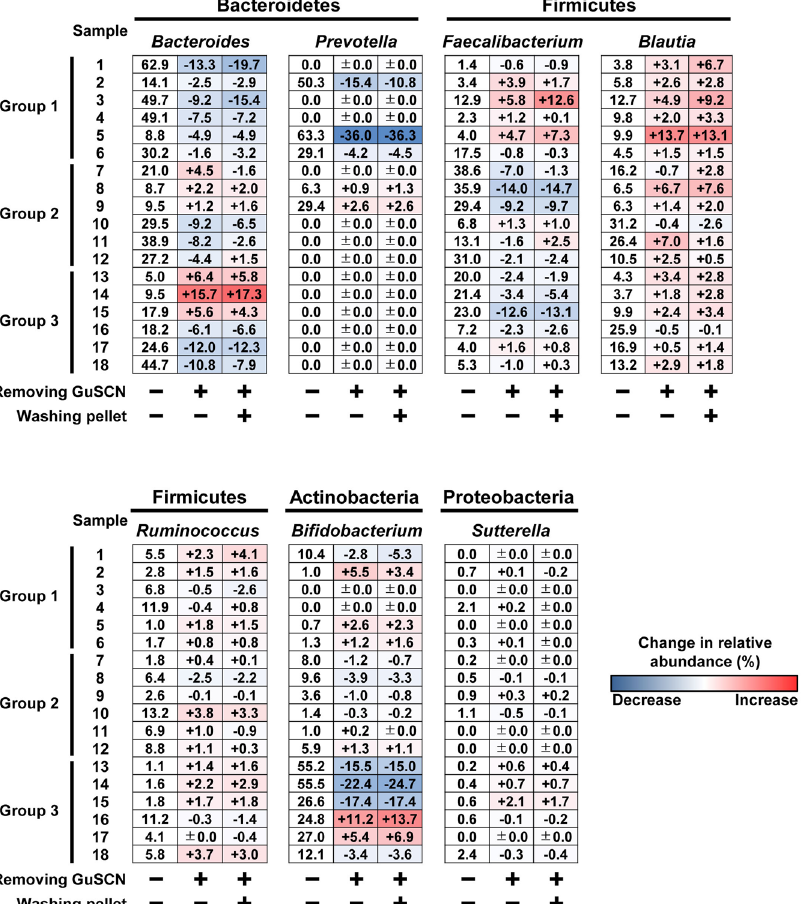
Figure 2. Effects of pretreatment on microbial composition in fecal samples at the genus level. The relative abundance (%) of Bacteroides , Prevotella , Faecalibacterium , Blautia , Ruminococcus , Bifidobacterium , and Sutterella in fecal samples collected from 18 individuals was shown. DNA was directly extracted from fecal samples in GuSCN solution (left column). The heat map (middle and right columns) shows the change in relative abundance (%) after pre-treatment in DNA extraction